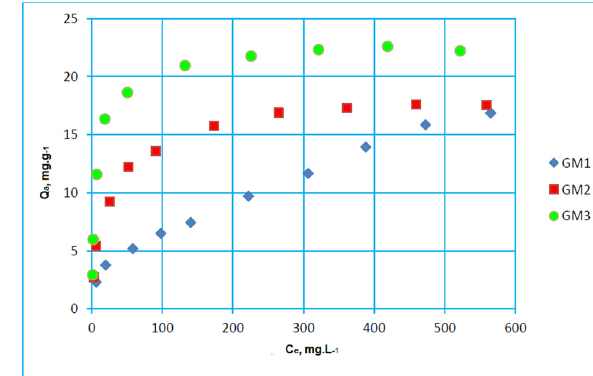
Figure 7: Paracetamol adsorption isotherm on GM1, GM2, and GM3 at 298